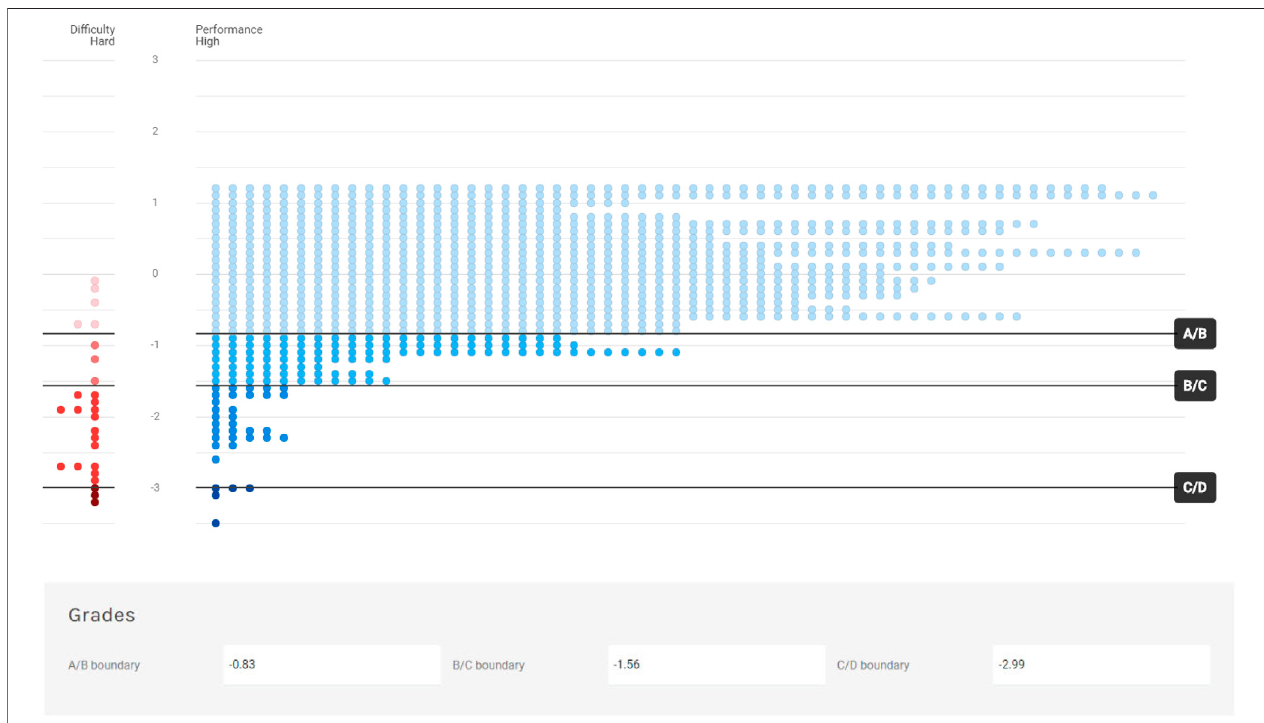
FIGURE 3 | SmartStandardSet standard setting display: Major grade